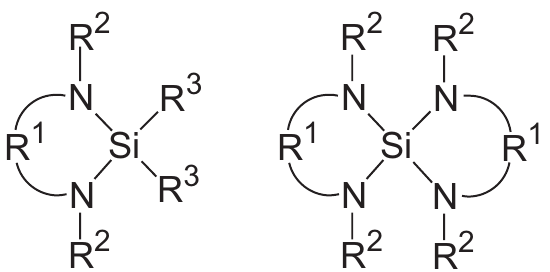
Figure 1: Generic structures of cyclic and spirocyclic aminosilanes in this work (with R 1 = ethylene, o-phenylene, 1,2-cyclohexanediyl, benzyl-2-yl, 1,8-naphthylene; R 2 = H, SiMe